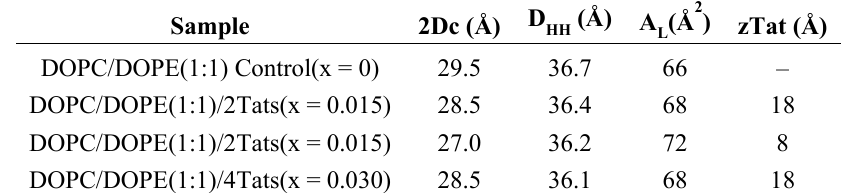
Table 1. Summary of DOPC:DOPE (1:1) bilayer perturbation by Tat 47–57 insertion.